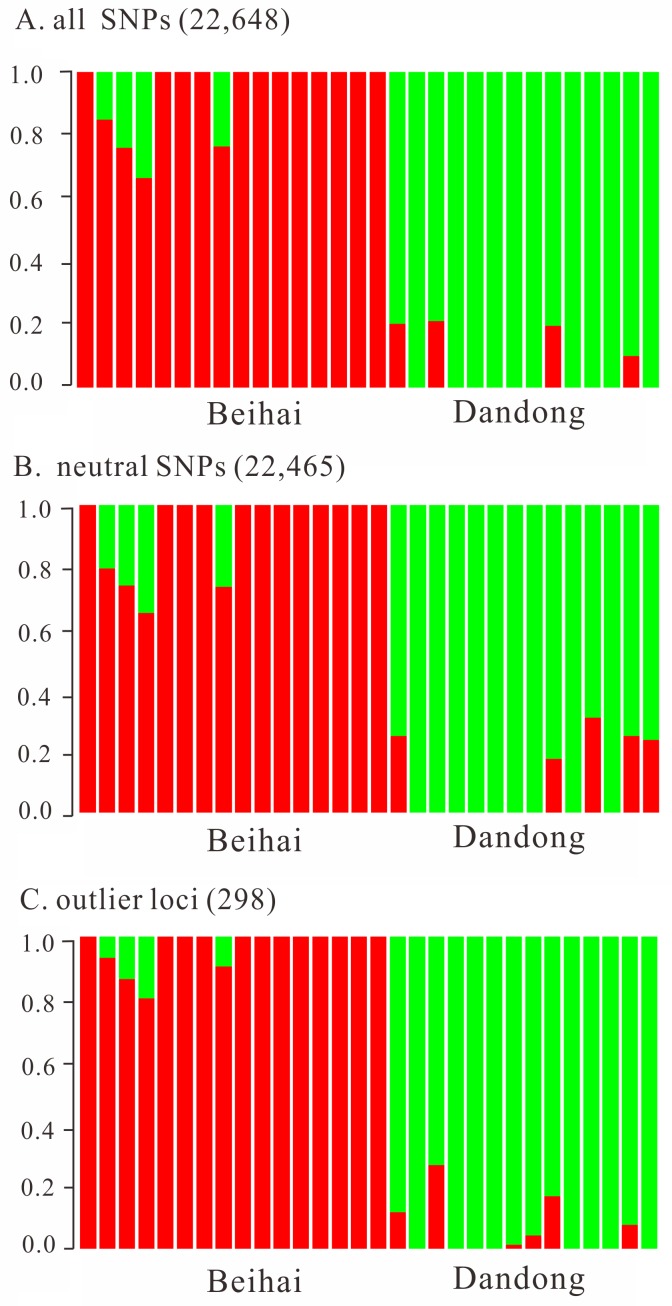
Admixture analysis of L. maculatus based on all, neutral and outlier SNPs.Each vertical line represents one individual, partitioned into segments according to admixture proportion of the spotted sea bass sampled from Dandong (green) and Beihai (red).